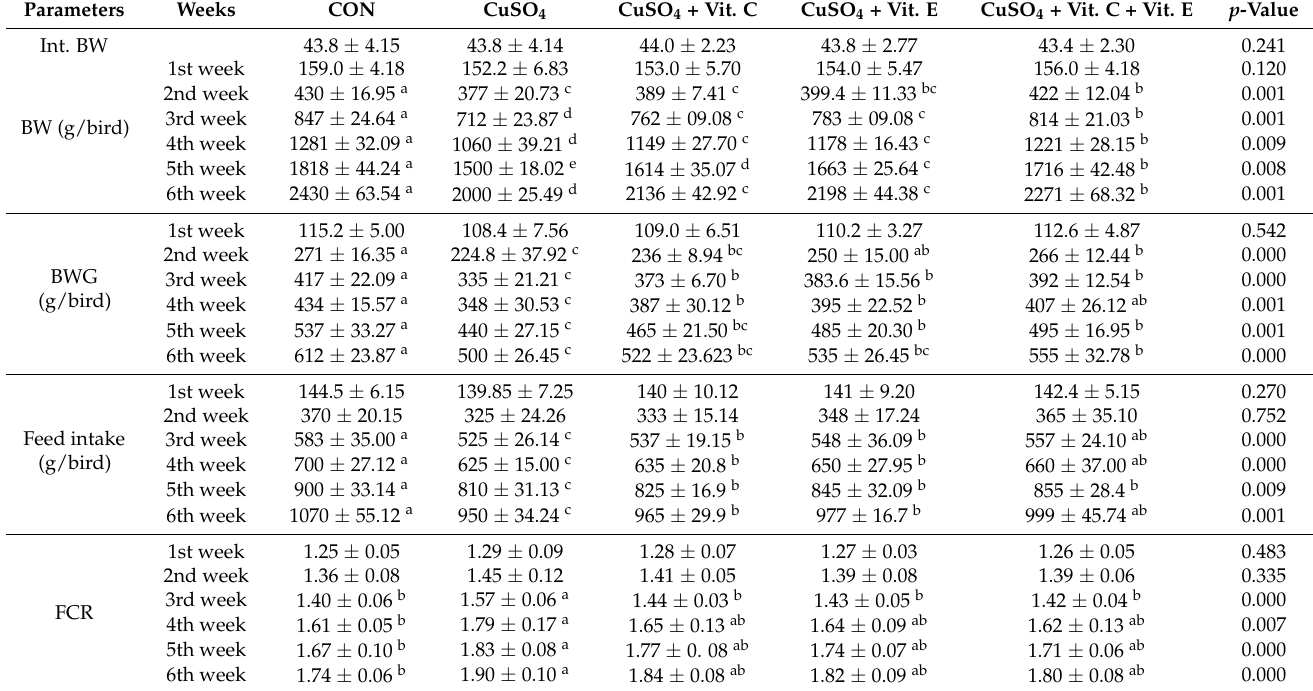
Table 2. Effect of single or combined supplementation of vitamin C and E on the growth performance of CuSO 4 -intoxicated broiler chickens (Mean ±